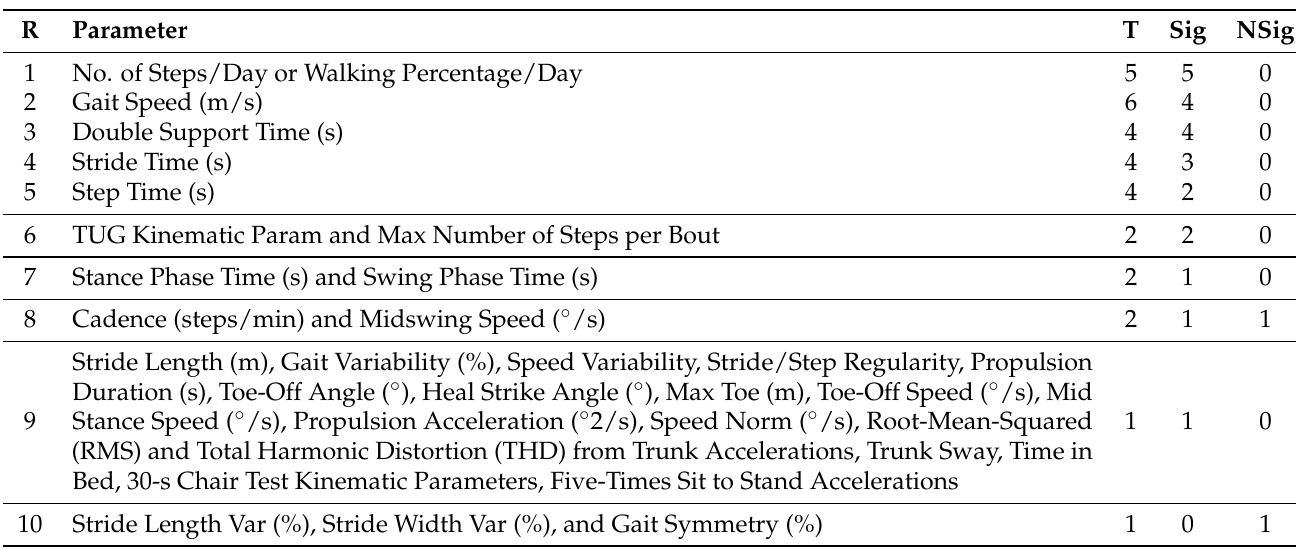
Table 7. Gait parameters related to frailty sorted by importance (total times and significance). R: Ranking, T: number of total Times that each parameter was included, Sig: number of times that each parameter is considered Significant, and NSig: number of times that a parameter is considered as “Nonsignificant” among frailty